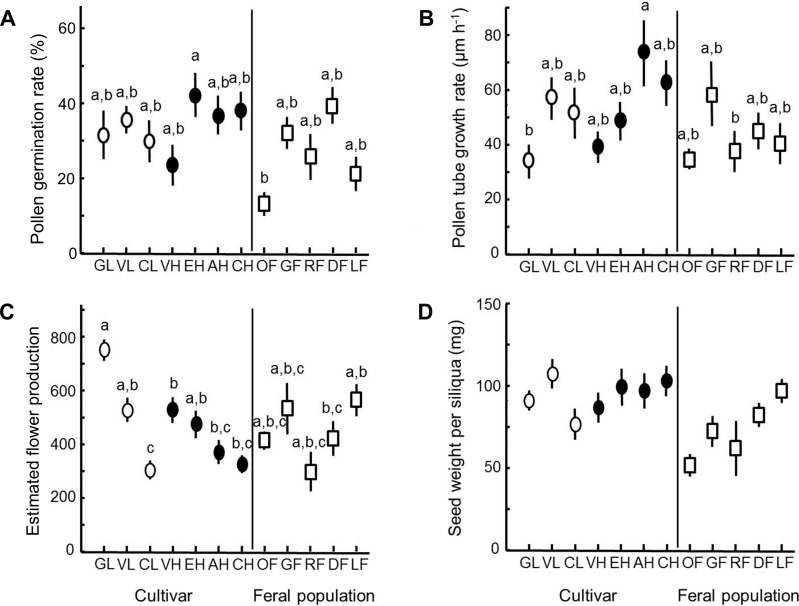
Variation in estimated traits in oilseed rape winter cultivars and feral populations.(A) Pollen germination rate in vitro, (B) pollen tube growth rate in vitro, (C) estimated flower production (= number of flowers on the main raceme times the number of branches), and (D) seed weight per siliqua. Most data were generated from plants grown in a common garden. For cultivars, data for C and D was pooled for plants grown in greenhouse and common garden, as no differences between growth conditions were found. Open circles = open-pollinated cultivars, filled circles = hybrid cultivars, open squares = feral populations. Error bars denote one standard error. Different letters above data points indicate significant differences in a posthoc test (Tukey HSD) involving both cultivated and feral plants (analysis 2). See S1 Table for an explanation of abbreviated cultivar/feral population codes.